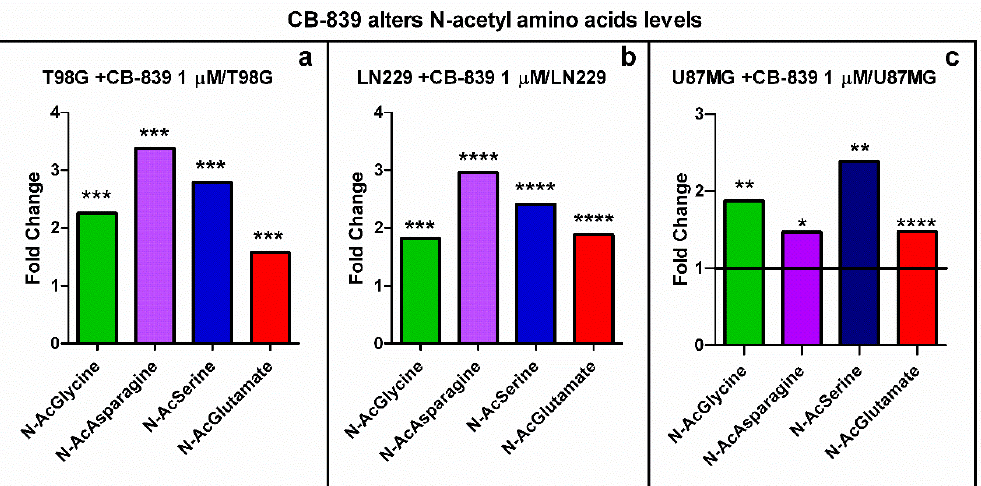
Figure 10. Increased levels of N-acetylated amino acids by specific GLS inhibitor CB-839 in LN229 ( a ), T98G ( b ), and U87MG ( c ). The samples were run in triplicate. For more details, see Section 2. * p < 0.05, ** p < 0.01, *** p < 0.001, **** p < 0.0001.